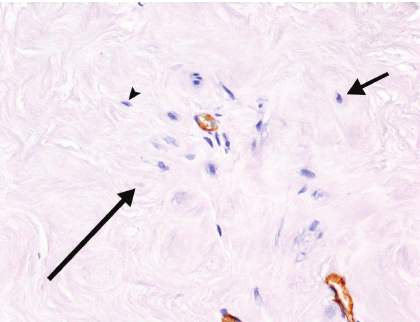
Figure 6: Phase 4 fibroid. Note that the only remaining viable cells in this field of a phase 4 fibroid are clustered around and between the two vessels. Most of these cells lie within 50–75 𝜇 m of the 2 capillaries.Thecellat2o’clock(shortarrow)islocatedalmost100 𝜇 m from the capillary in the center, and there are no viable cells beyond this point. The cell marked by an arrowhead is 50 𝜇 m from the central vessel, and the apparent nuclear ghost (long arrow) is 70 𝜇 m from the vessel. This suggests that in the setting of hyalinized fibroid stroma the maximum cell to vascular distance that is compatible with cell survival is in the range of 70–100 𝜇 m, and that other factors such as the local density of the stroma may also play a role. 20x, anti- Factor 8